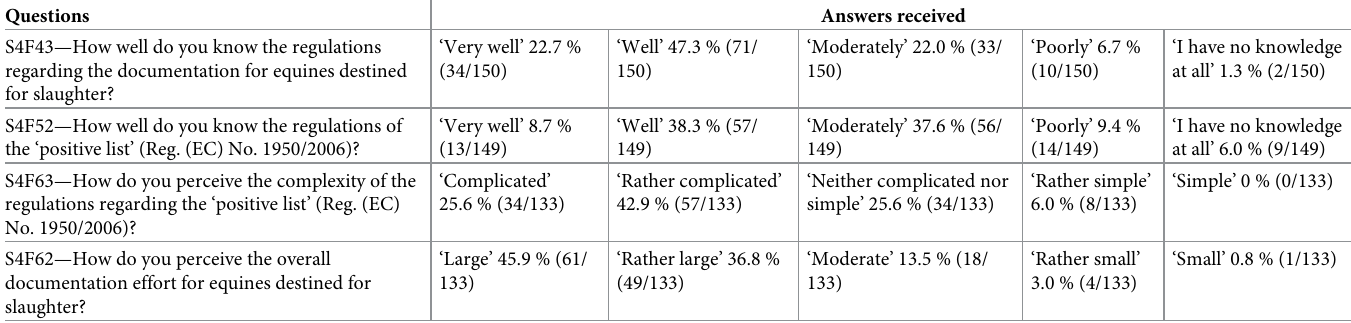
Table 3. Description of veterinarians’ self-assessed knowledge regarding different regulations concerning slaughter